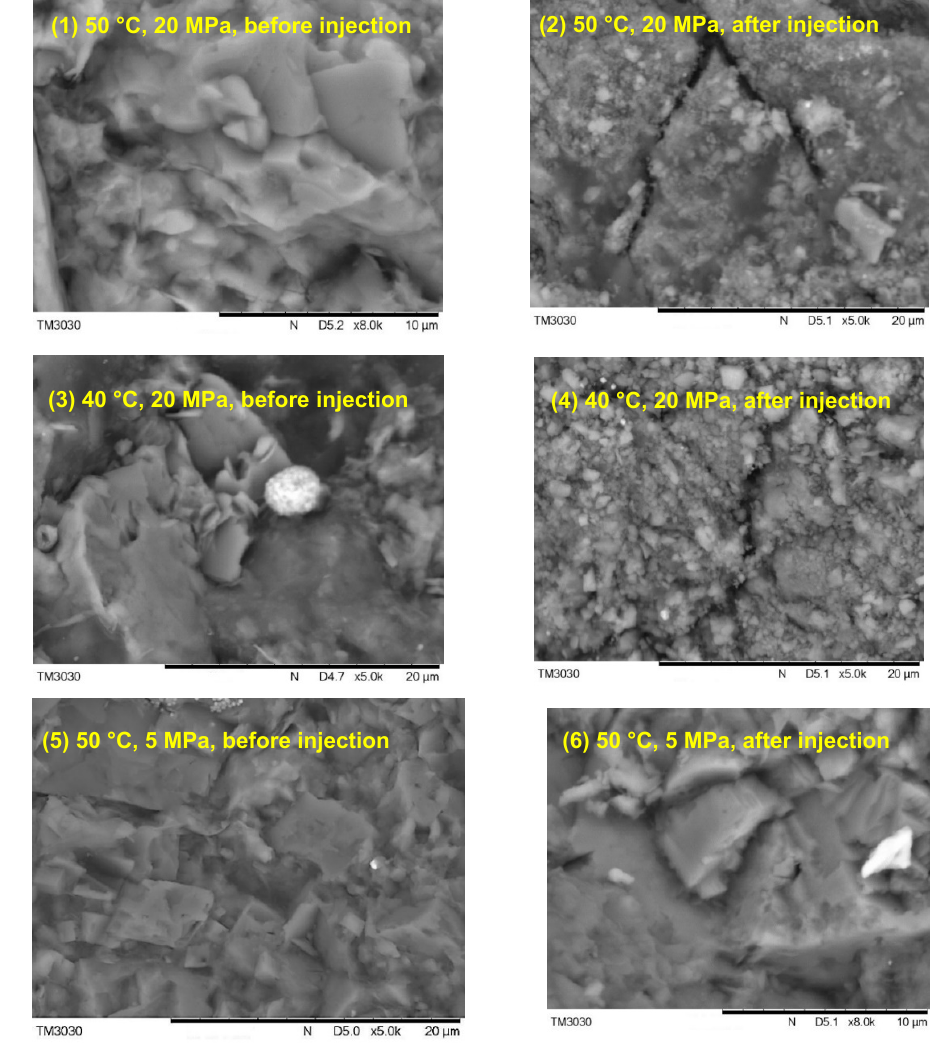
Figure 17. Comparison of the microscopic surface morphology of three specimens before and after CO 2 injection for the validation experiment.